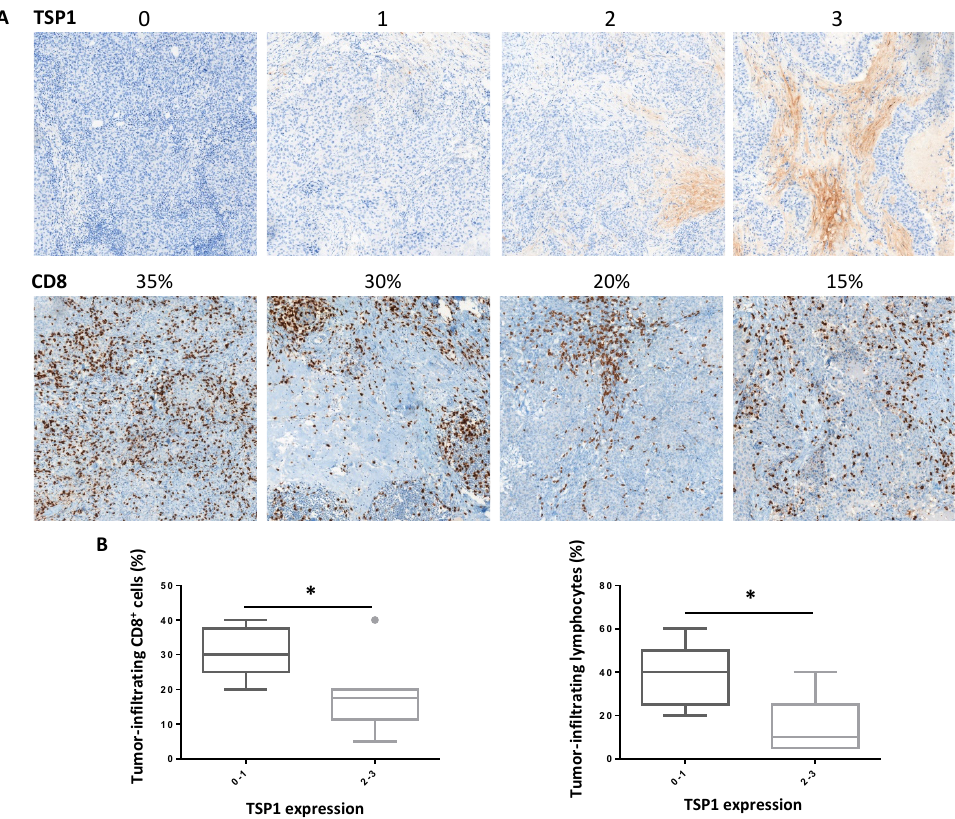
Figure 2. TSP1 expression and tumor-infiltrating lymphocytes in TNBC breast cancer patients. ( A ) Illustration of TSP1 immunodetection in TNBC breast cancer. The values indicate the scores associated with TSP1 expression. Examples of immunohistochemical (IHC) staining of CD8+ TILs obtained on TNBC breast cancer specimens to determine the proportion of CD8+ TILs. ( B ) Proportion of CD8+ (left panel) and total (right panel) TILs on tumor samples from 12 TNBC patients exhibiting low (score 0–1) or high (score 2–3) TSP1 expression (*: p < 0.05).